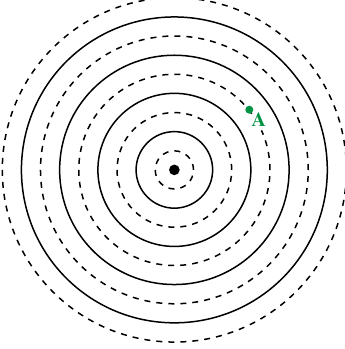
FIG. 5 (color online). Diagram shown to students as part of the single-source problem.